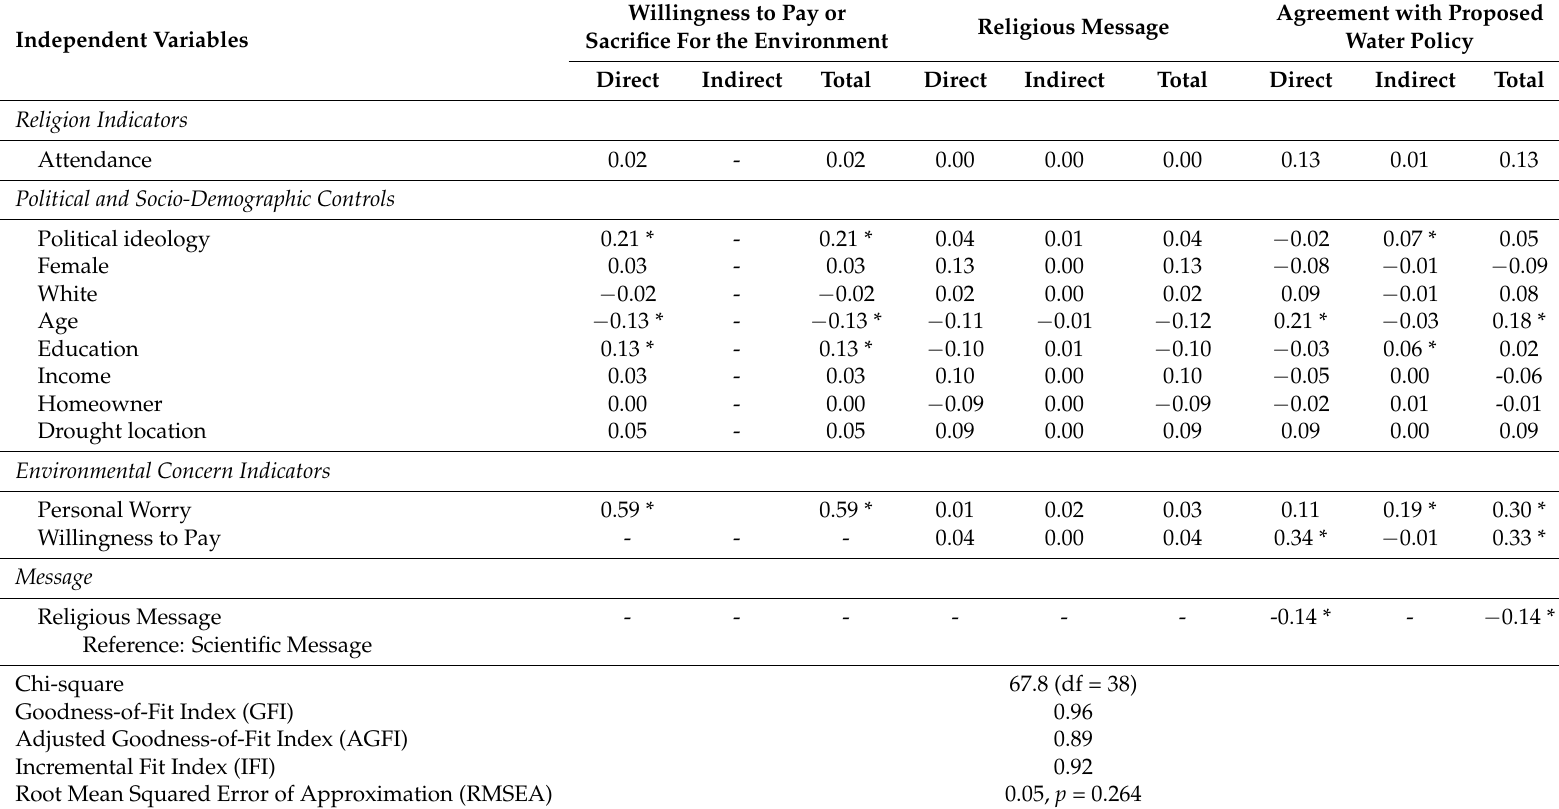
Table 3. Standardized coefficients from structural equation model predicting agreement with proposed water policy, Christian subsample (N = 206).